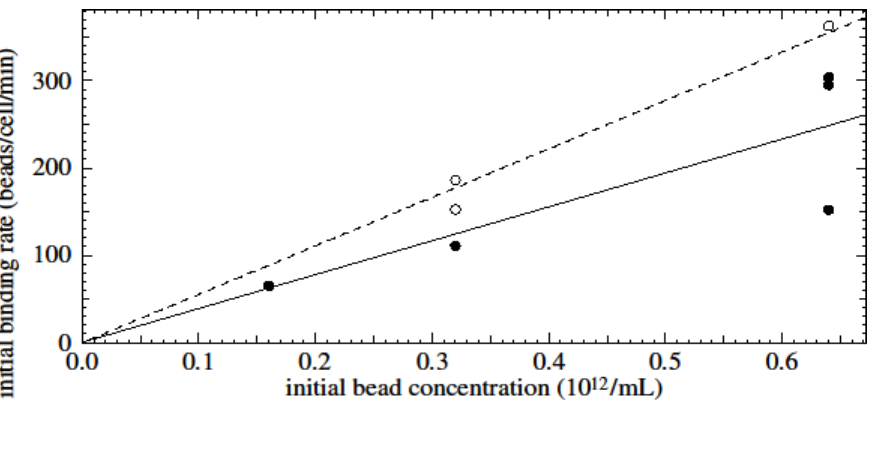
Figure 8. Initial rate of bead-cell binding as a function of initial bead concentration. Solid line and dots: CD3; dashed line and circles: